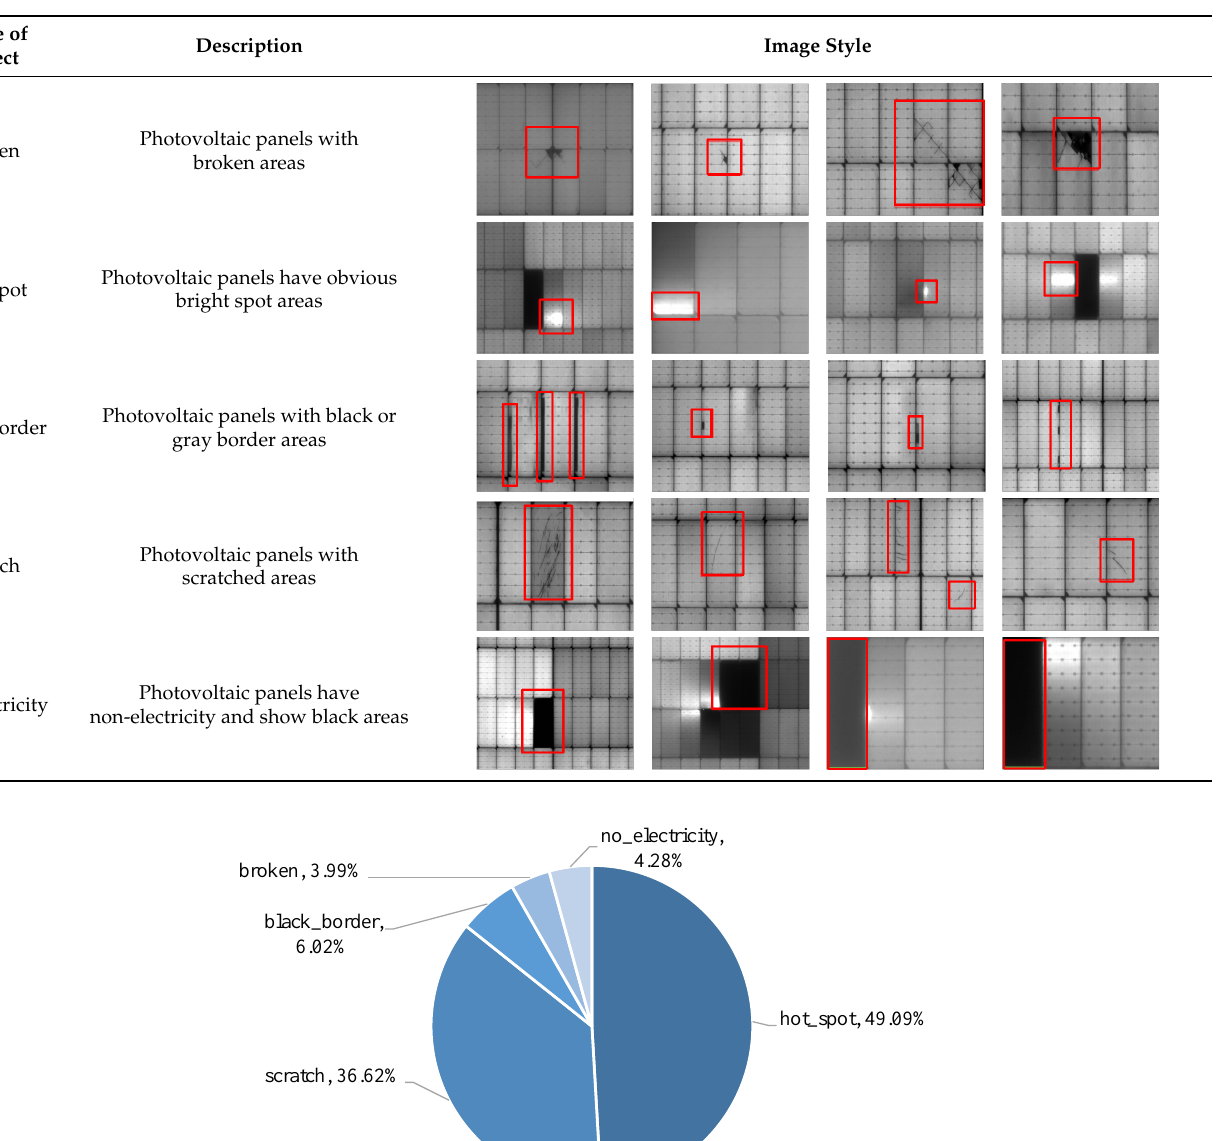
Table 1. Defect sample diagram.